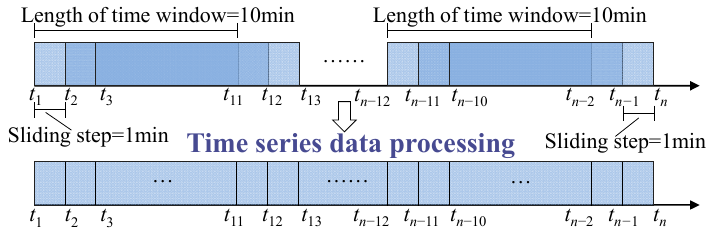
Figure 11. Time series data processing.